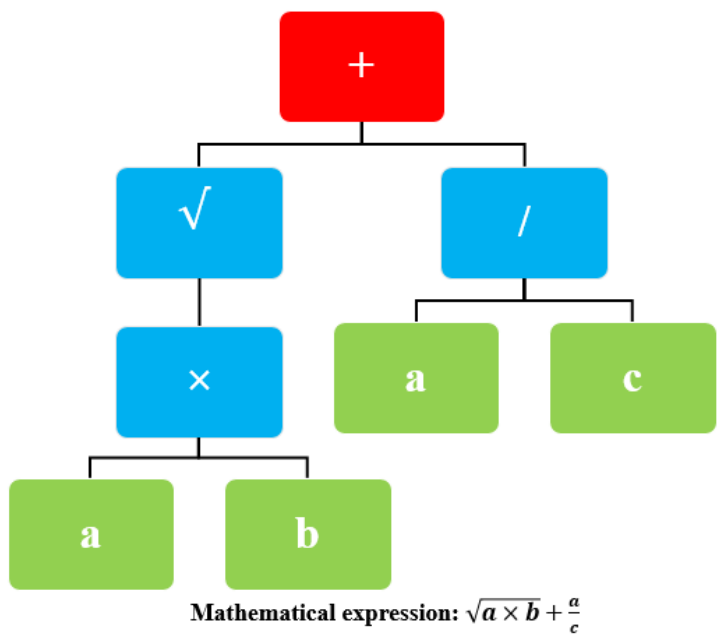
Figure 4. A two-gene chromosome illustrated in the form of tree codification.